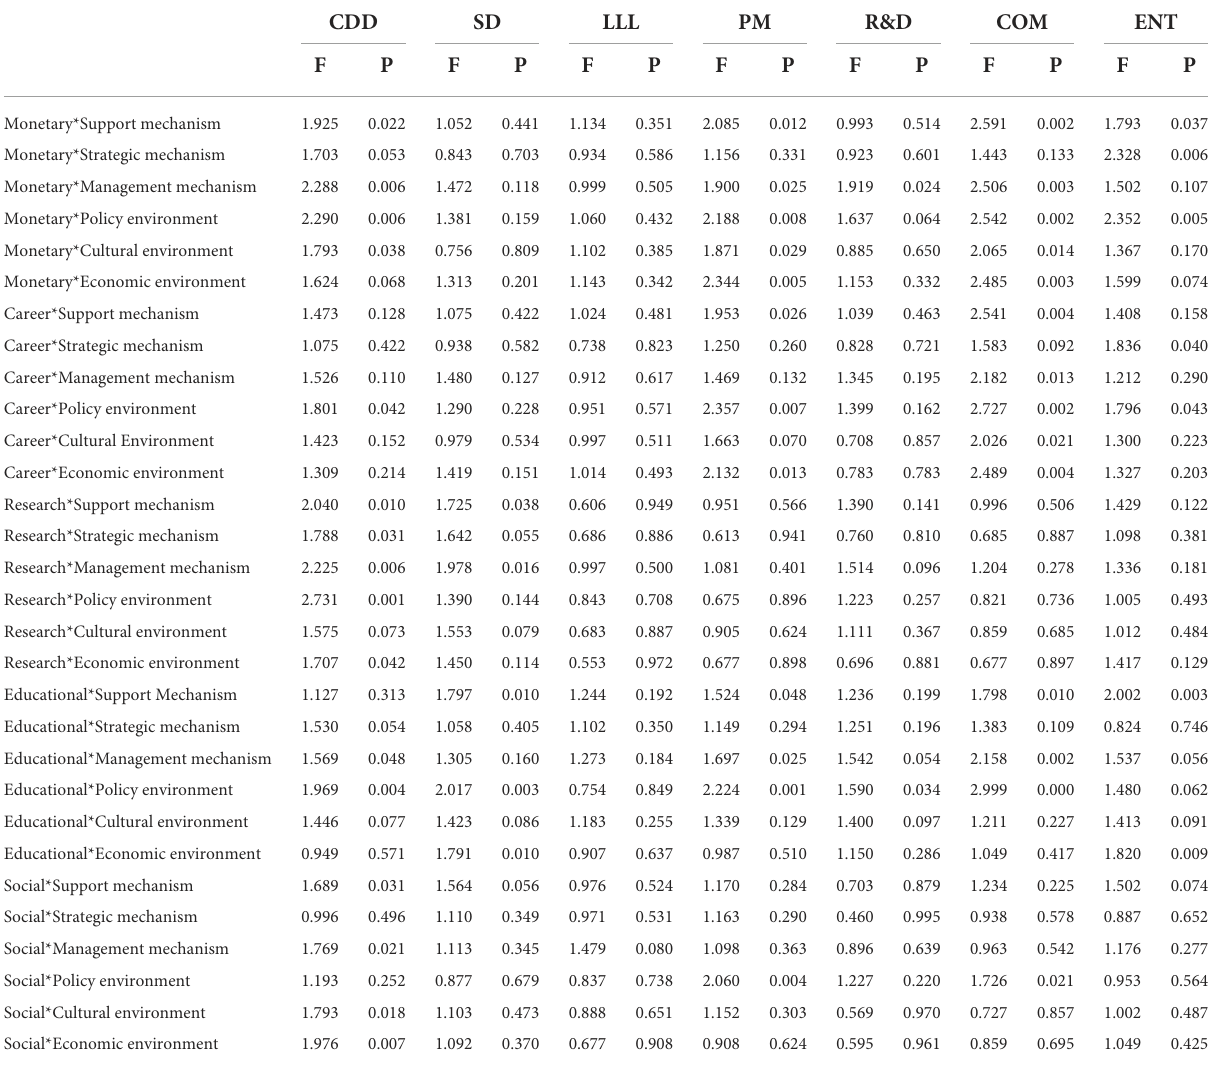
TABLE 2 Results of GLZM (regulatory effects of moderator